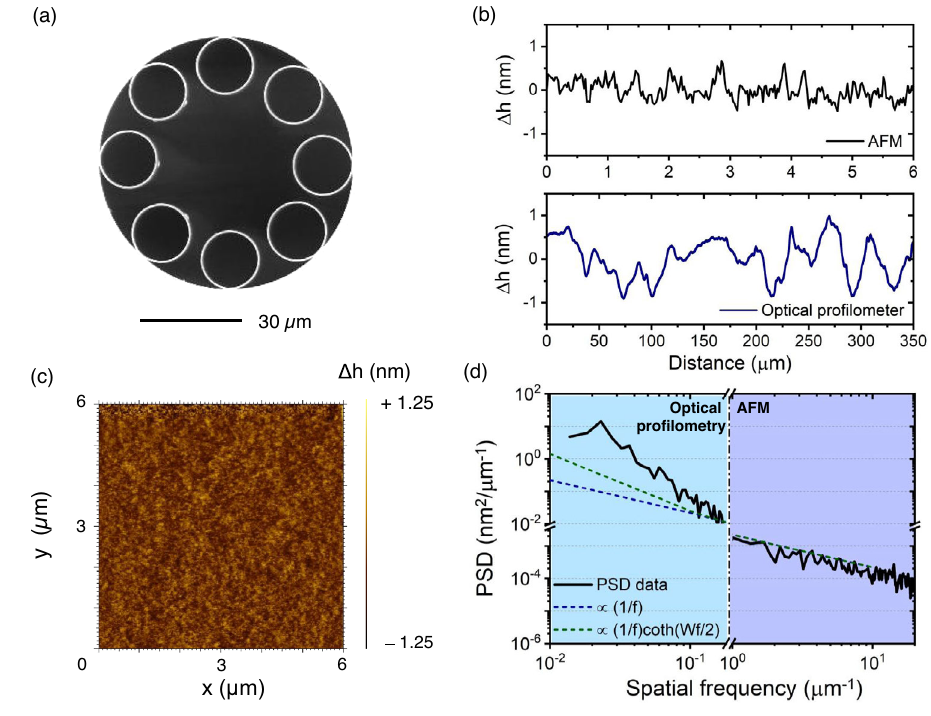
fabrication methods. d PSD plot accounted from optical pro fi lometry and AFM measurements and PSD trend lines. AFM atomic force microscopy, PSD power spectral